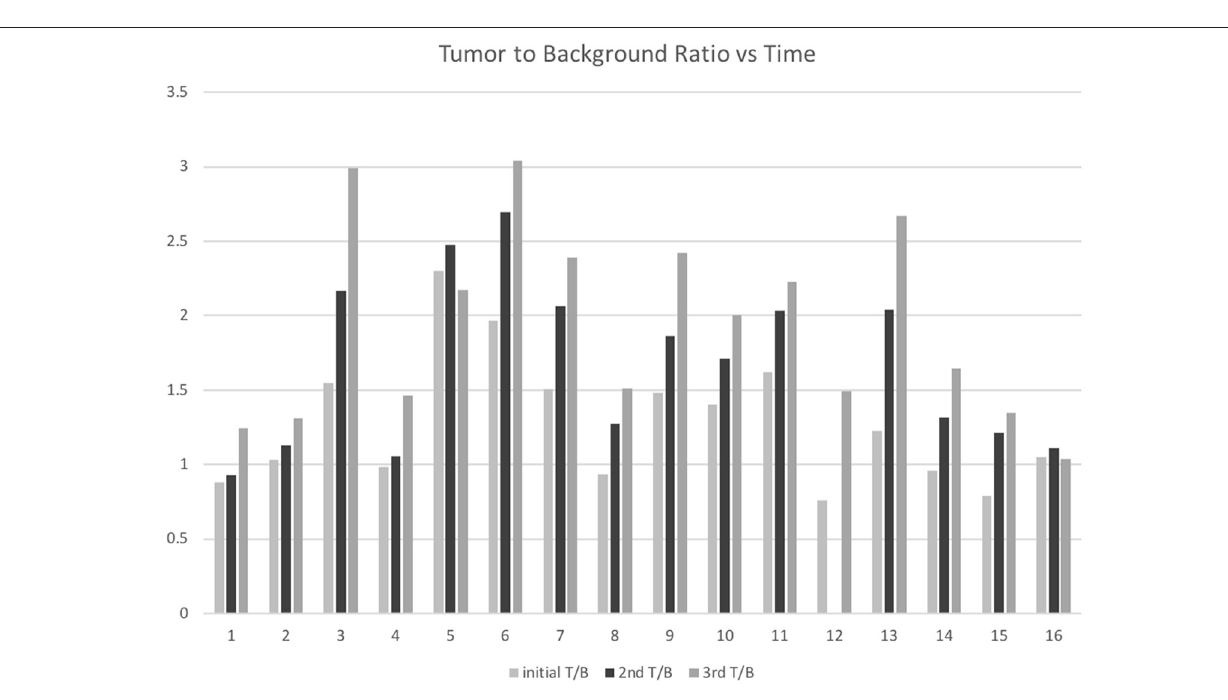
Figures 3 , 4 . The mean rating at 1 h was 4.1 ± 1.5, at 5 h was 4.8 ± 0.7, and at 8 h was 5.0 ± 0.4. The 5 h imaging was considered superior compared to 1 h ( p > 0.0001), 8 h was considered